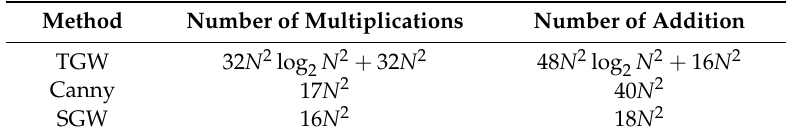
Table 3. The computational times comparison of traditional Gabor wavelet (TGW), Canny and SGW [45].